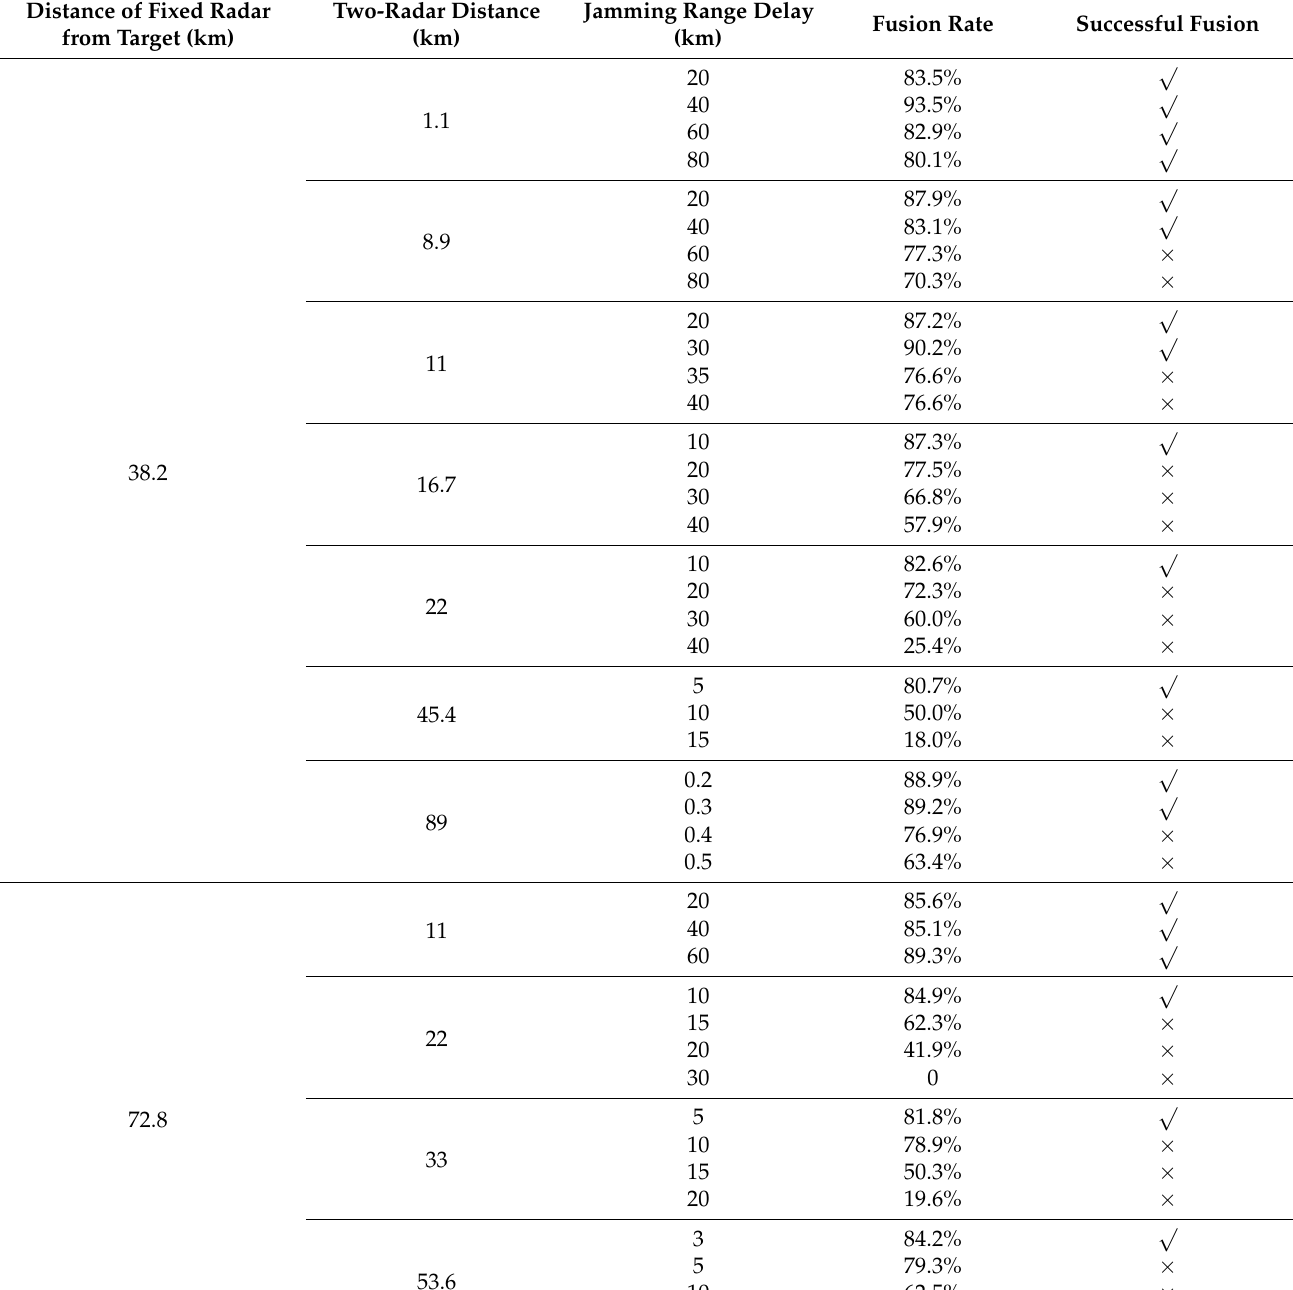
Table 4. Jamming performance evaluation results of a ground-based radar network (two radars). Distance of Fixed